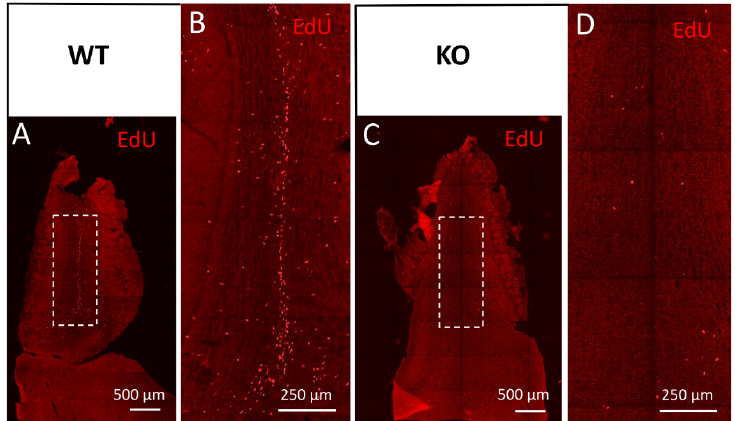
Figure 5. Cyclin D2-KO mice show reduced numbers of EdU(+) cells in the olfactory bulb. ( A – D ) Detection of EdU in horizontal sections of the olfactory bulb from ( A , B ) WT, and ( C , D ) cD2-KO mice. Cyclin D2 deficiency downregulates cellular proliferation activity and/or migration, shown as EdU(+) profiles present in ( C , D ) the white square in the granule cell layer, compared to ( A , B ) the WT mice. Note the striking difference in the number of EdU(+)-labelled newly generated or migrated cells between the WT and cD2-KO mice.